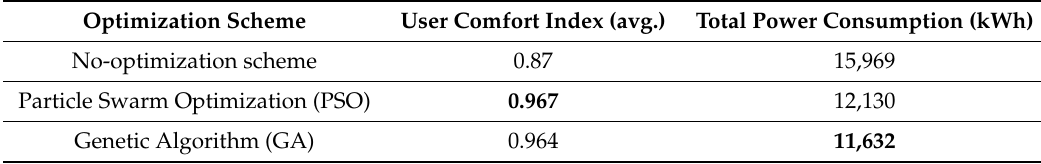
Figure 10. Results comparison of GA, PSO and the no-optimization scheme: first five days (125 h) of results. Table 5. Optimization schemes’ result